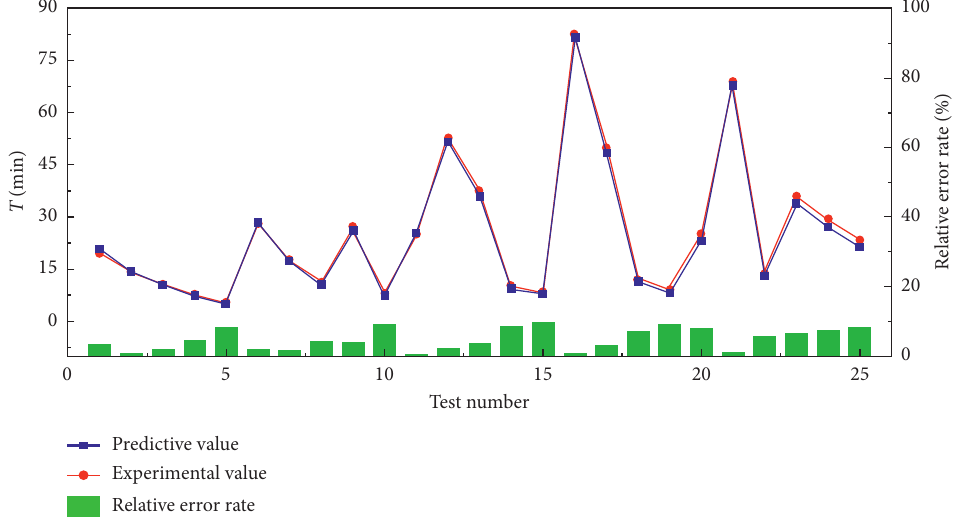
Figure 3: Comparison of numerical simulation values and formula calculation